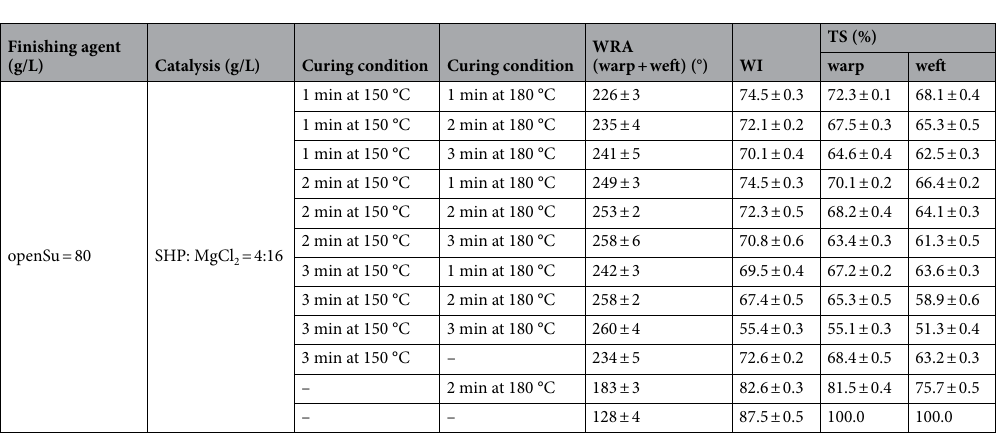
Table 2. Anti-wrinkle properties of treated cotton fabrics under different curing